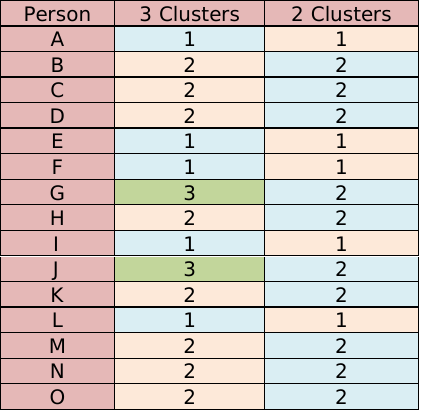
Table 3. “Cluster Analysis for Sub Criteria –